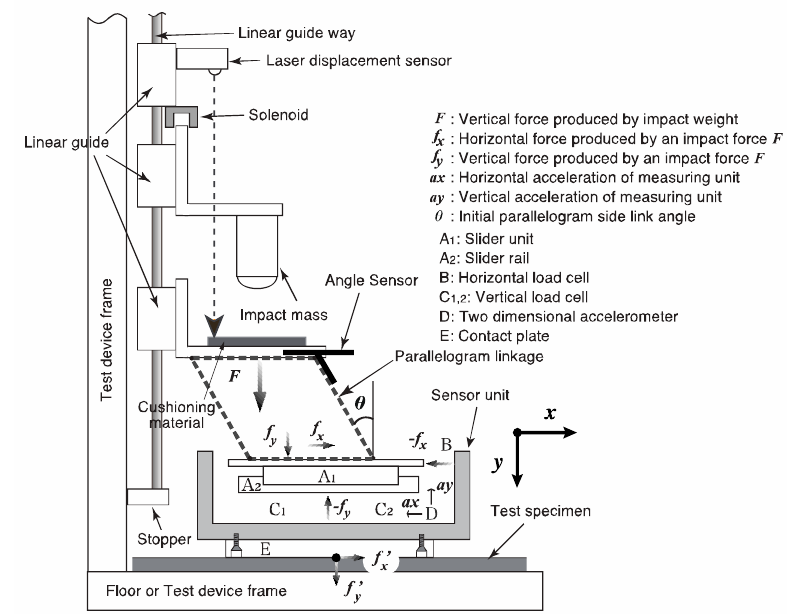
Figure 1. 2-D impact test device. According to the parallelogram linkage, the impact force produced by impact mass onto the upper edge of the linkage is divided into the vertical force f y and the horizontal force f x and applied to the test